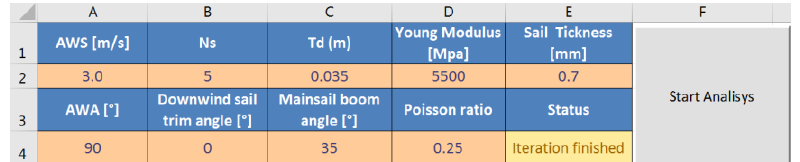
Figure 14. MS Excel user interface.